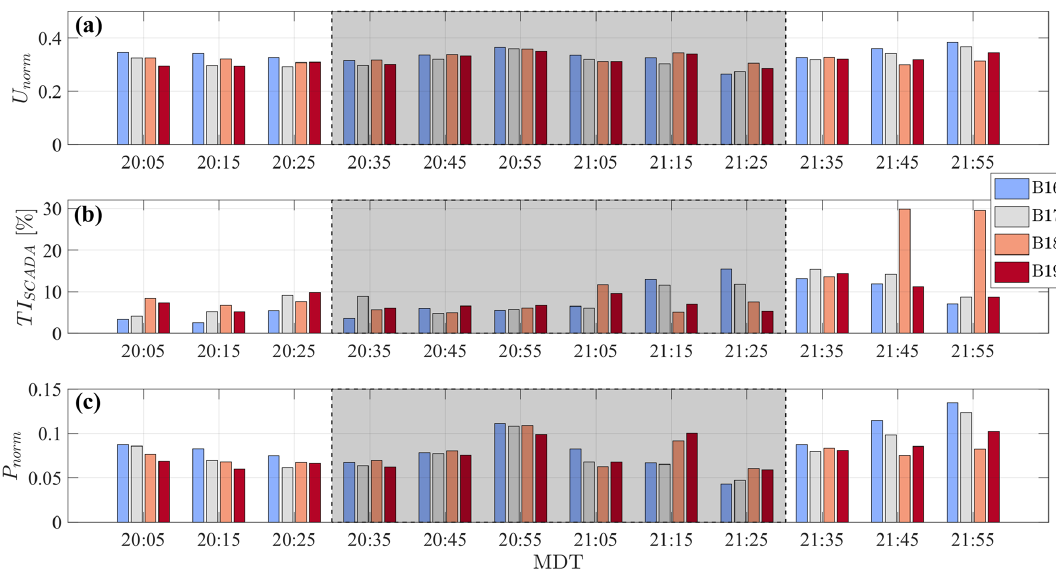
Figure 8. SCADA data during the selected testing period. (a) Normalized hub height velocity. (b) Turbulence intensity. (c) Normalized